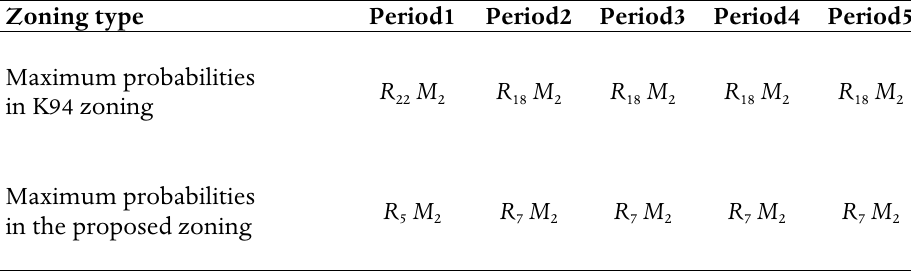
Table 3. Summary of maximum probabilities in the two types of zoning.